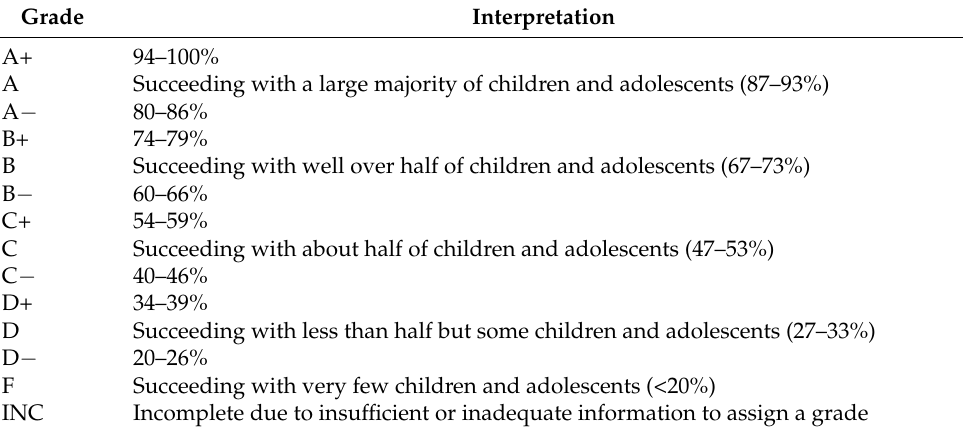
Table 2. Global Matrix 4.0 grading rubric 1